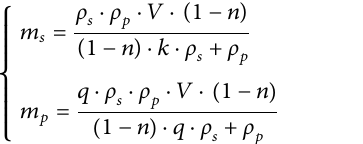
Frontiers in Earth Science |